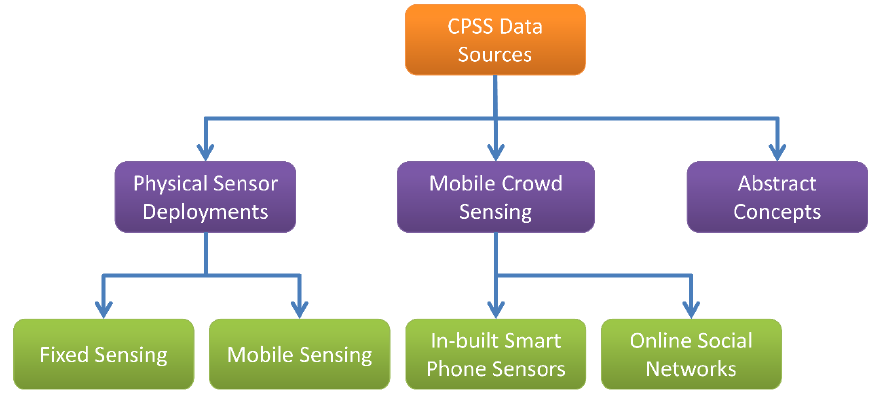
Figure 5. A taxonomy of CPSS data sources.